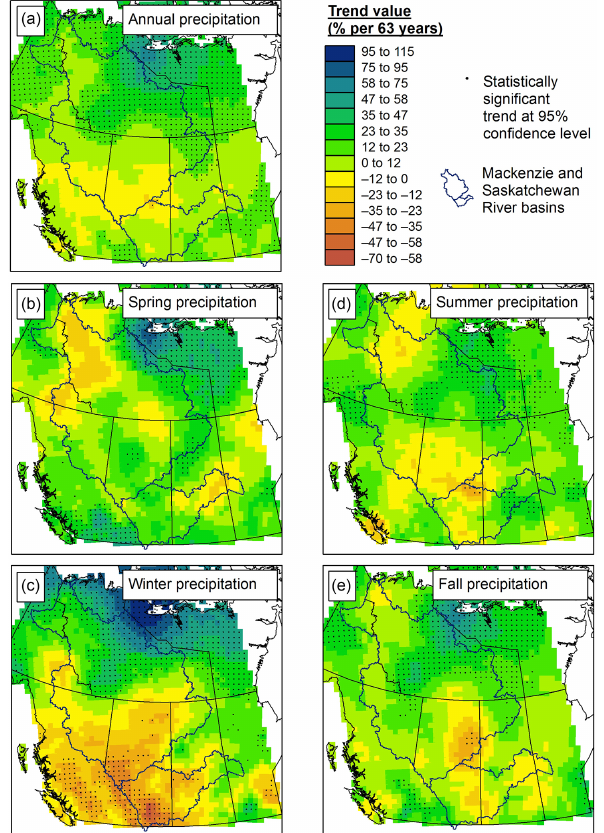
Figure 4. Spatial patterns of trends (percent per 63 years) in an- nual and seasonal totals of precipitation over the period 1950–2012 across western Canada, based on analysis of CANGRD precipita- tion